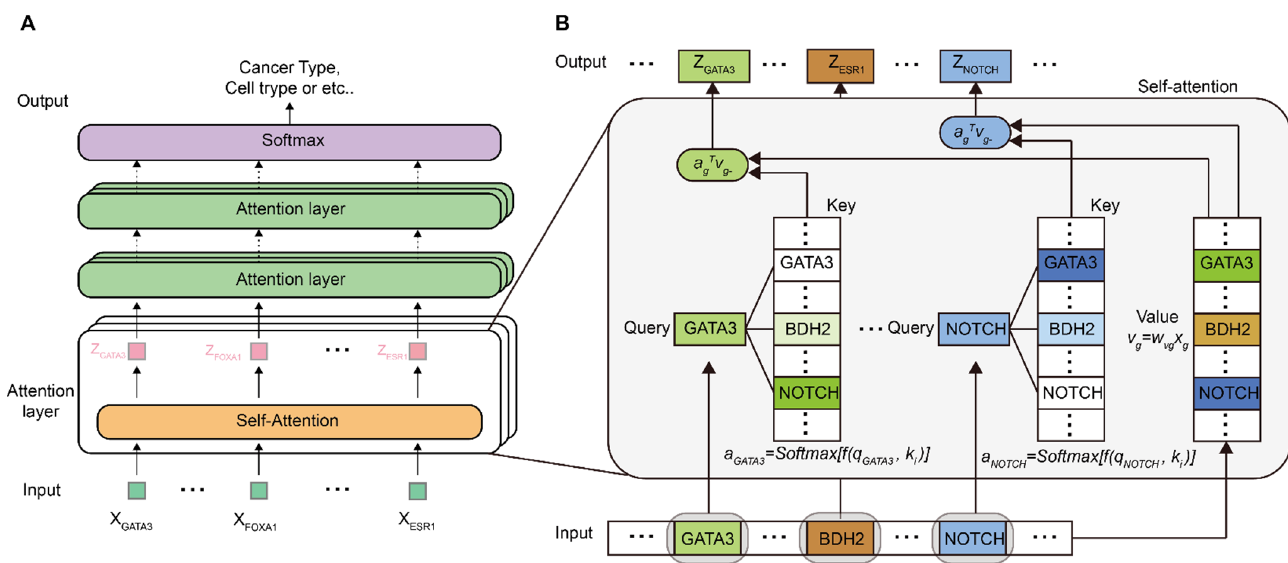
Figure 1. Illustration of the proposed T-GEM model. ( A ) General structure of T-GEM. ( B ) Detailed structure of a head in the first attention layer.